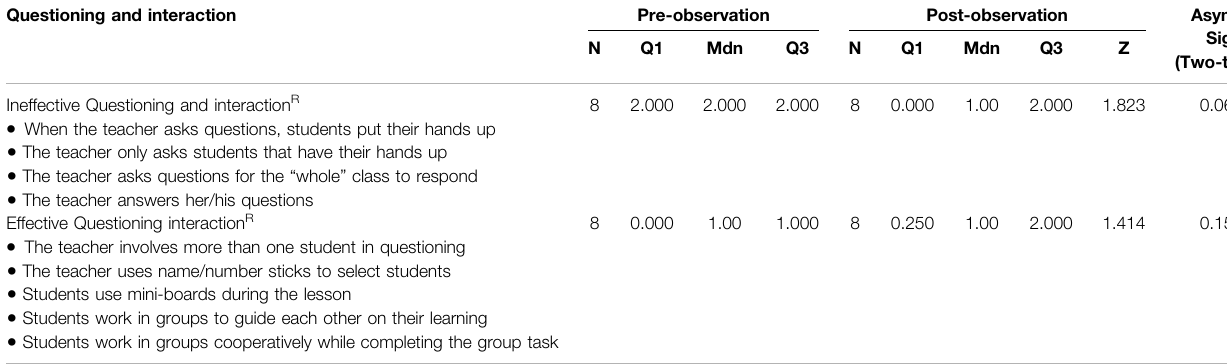
TABLE 4 | Rating results for using questioning within FAHOTS as observed by the researcher during pre- and post-observations. Questioning and interaction Pre-observation Post-observation